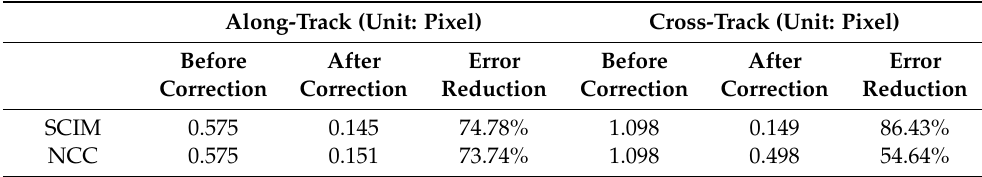
Table 2. Comparisons of the geolocation errors of the MWRI brightness temperature images corrected by SCIM and NCC. Along-Track (Unit: Pixel) Cross-Track (Unit: Pixel) Before After Error Before After Error Correction Correction Reduction Correction Correction Reduction SCIM 0.575 0.145 74.78%